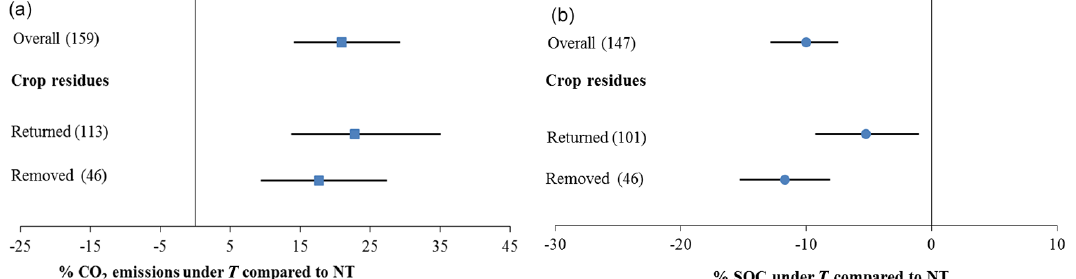
Figure 7. Percent change in (a) soil CO 2 emissions and (b) SOC in tillage ( T ) soil compared to no-tillage (NT) as a function of crop residues (returned and removed). The numbers in the parentheses indicate the direct comparisons of the meta-analysis. Error bars are 95% confidence intervals.